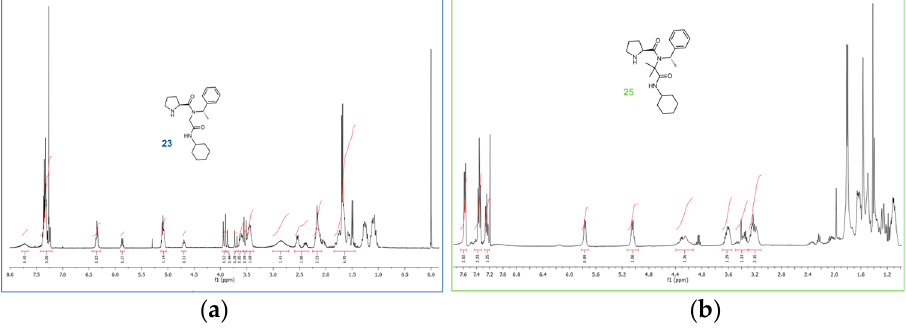
Figure 6. ( a ) 1 H NMR spectra of catalyst 23 in CDCl 3 (400 MHz); ( b ) 1 H NMR spectra of catalyst 25 in CDCl 3 (600 MHz). The figure is prepared from data published previously [38].